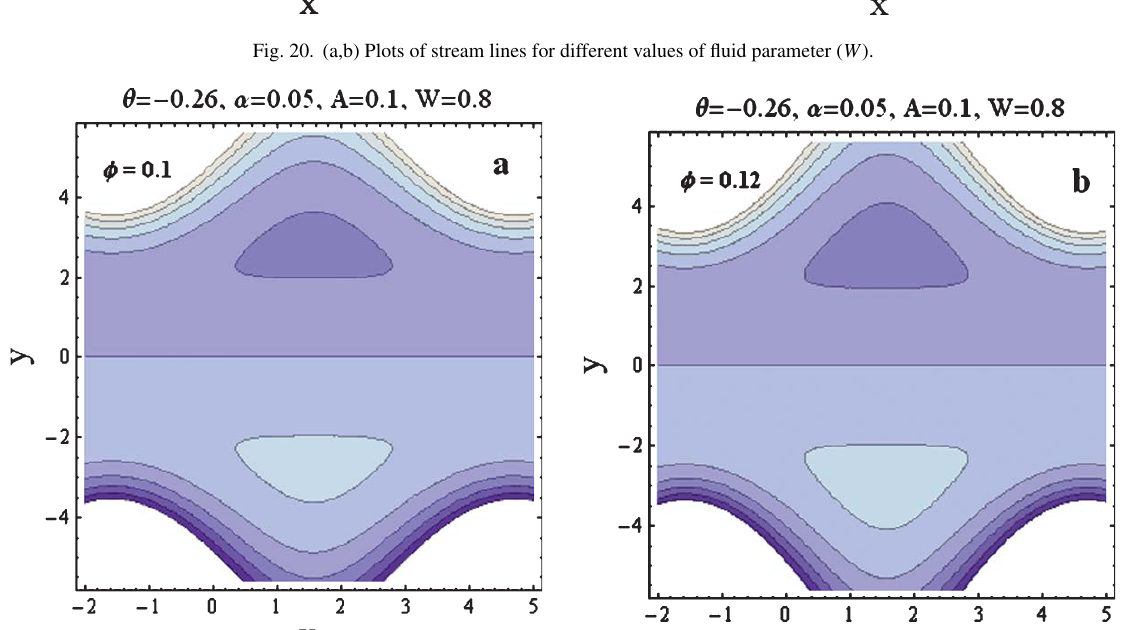
Fig. 20. (a,b) Plots of stream lines for different values of fluid parameter ( W ).